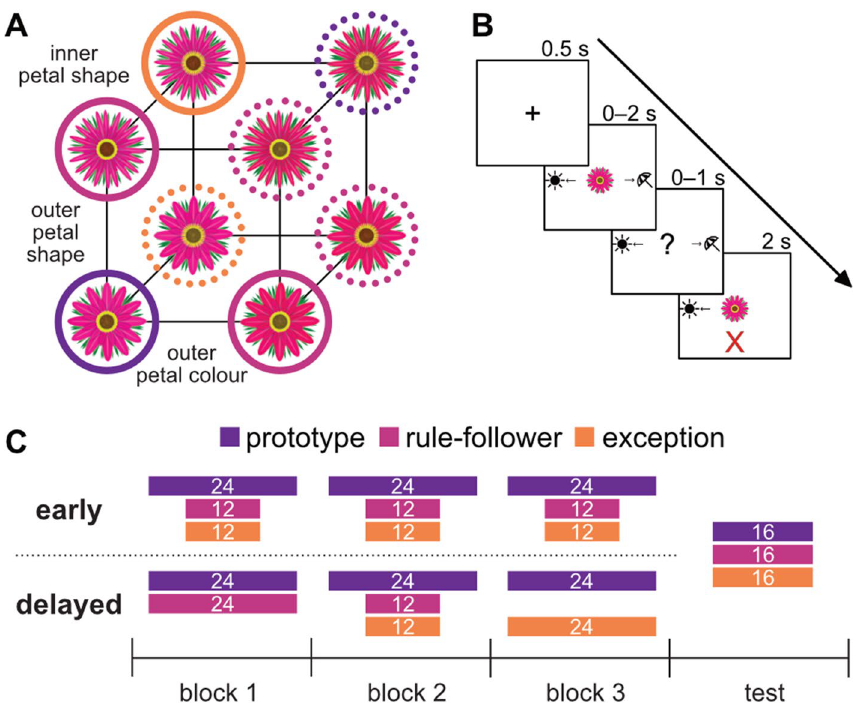
Figure 1. Experimental design. ( A ) Flowers were categorized using the Type III problem defined by 24 . Flowers varied across three binary-valued diagnostic dimensions and were defined as prototypes (circled in purple), rule-followers (circled in pink), and exceptions (circled in orange). Line type (solid or dashed) indicates category membership. ( B ) In learning trials, participants were exposed to stimuli and were asked whether the presented flower preferred sun or shade. They were required to make a category response within 2 s. After making a response, participants received feedback for 2 s before proceeding to the next trial. Testing trials followed a similar pattern, but no feedback was provided. The test block was followed by a recognition memory task (not shown). ( C ) The breakdown of stimulus types across conditions. The numbers of prototypes, rule-followers, and exceptions per block are denoted with purple, pink, and orange rectangles, respectively. Each block has 48 trials, and the width of the rectangles in ( C ) is proportional to the number of trials per type. In the “early” condition, participants saw exceptions in learning block one; in the “delayed” condition, exceptions were not introduced until the second learning block. The total number of stimuli and the structure of the test block were identical across